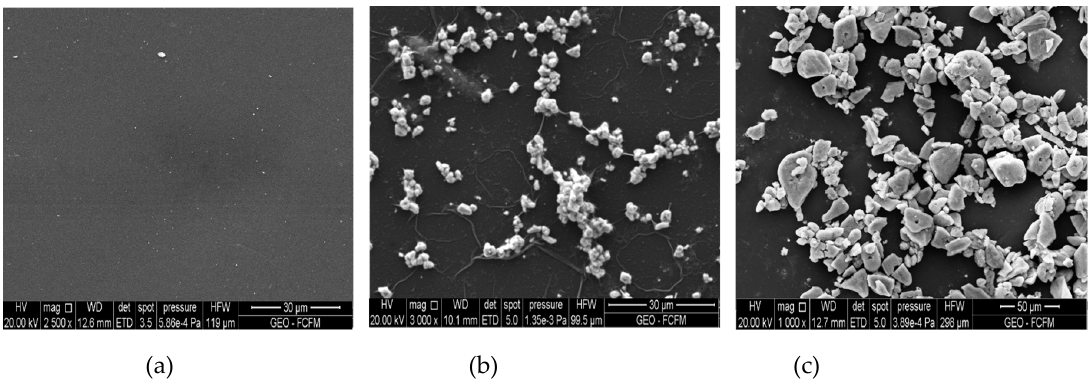
Figure 3. SEM images of the membrane surface ( a ) PA-PSL; ( b ) PA+0.25Cu-PSL; ( c ) PA+0.25Fe-PSL.